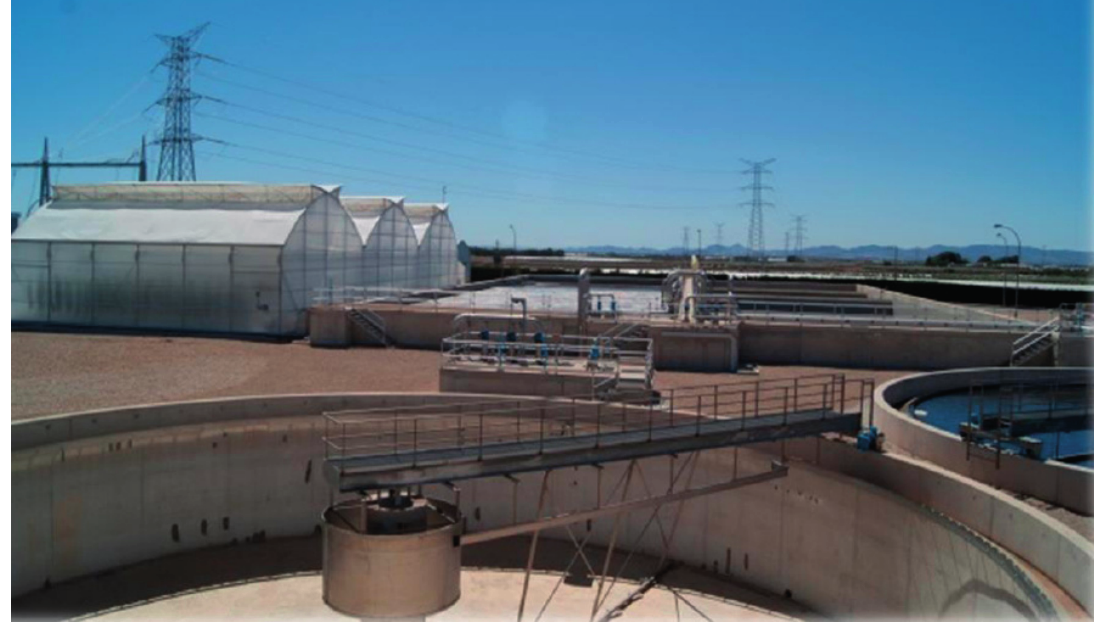
Figure 1. A secondary treatment wastewater plant located in a greenhouse production unit to provide irrigation water for tomato production. Reprinted with permission of Quality and Safety Lab